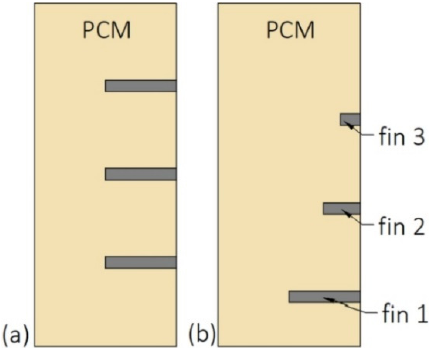
Figure 14. The length and arrangement of fins: ( a ) Equal-length fins; ( b ) fins moved down, the length of fin 2 and 3 reduced by 50% and 75%, respectively, compared to fin 1 [26].